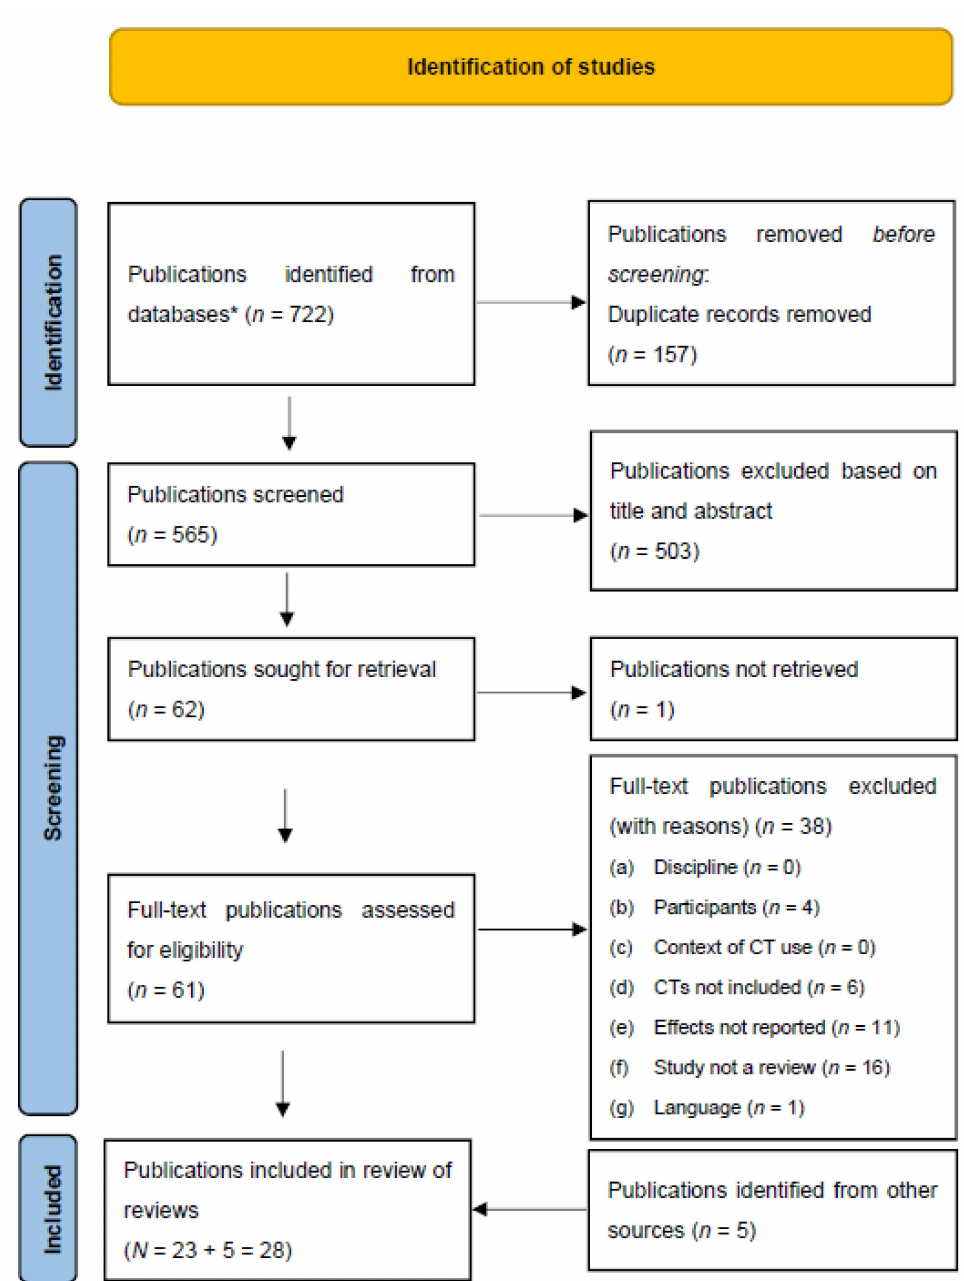
Figure 1. Literature Identification, Screening, and Inclusion for the Scoping Review of Reviews Addressing the Impact of Communication Technologies (CTs) on Loneliness and Social Isolation Among Older Adults. Note. Scoping review procedure for literature search, screening, and selection. Figure created following PRISMA-ScR guidelines. Searched databases: (1) MEDLINE, (2) Institute of Electrical and Electronics Engineers (IEEE) Xplore, (3) Association for Computing Machinery (ACM) Digital Library, (4) Scopus, and (5) PsycINFO. Results for each database: MEDLINE ( n = 113), IEEE ( n = 14), ACM ( n = 15), Scopus ( n = 555), and PsycINFO ( n =